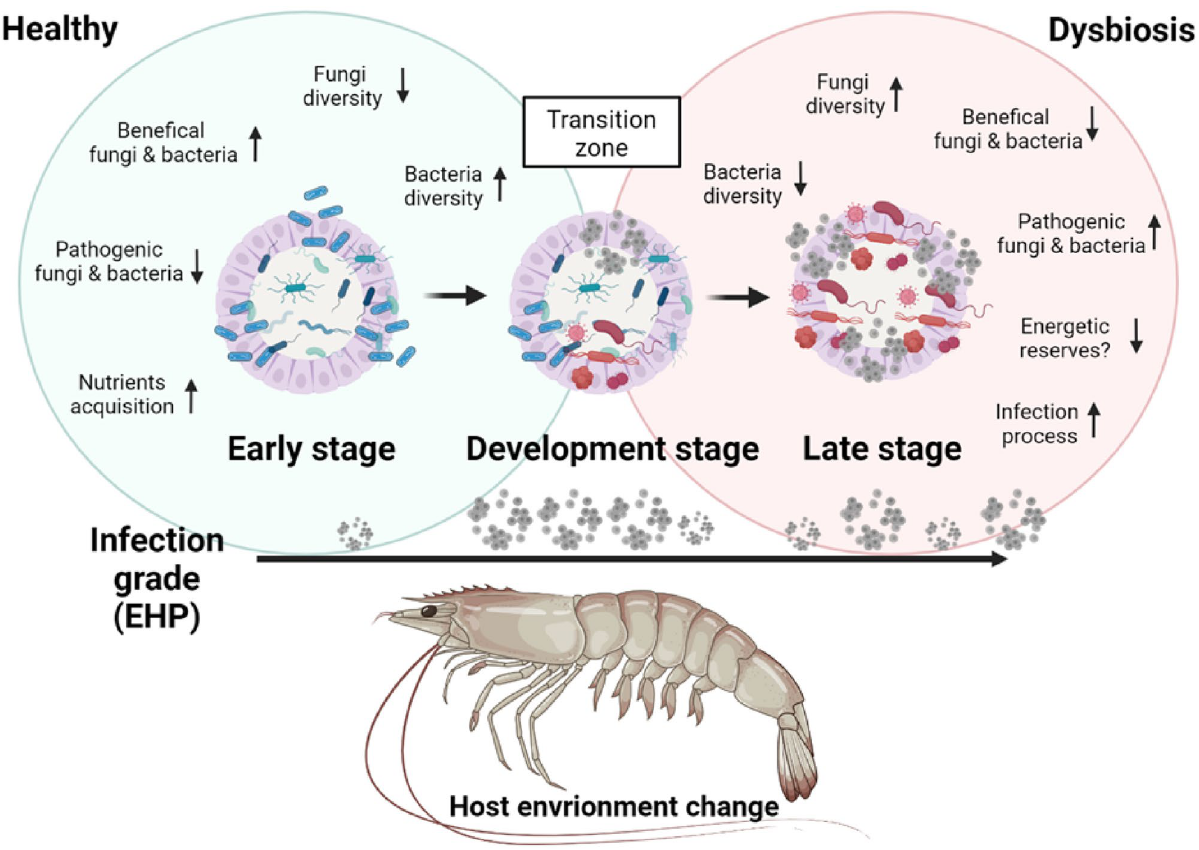
Figure 8. Modulation of the microbiome in the hepatopancreas of shrimp ( P. vannamei ) infected with EHP. Schematic diagram that represents the main changes produced in the host hepatopancreatic environment during the infection of EHP (30 days) according to the disease stages registered in this study. Infection intensity represents the cyclic patter of EHP, where bigger EHP figures represent higher infection grade and smallest EHP figures represent lower infection grade. Blue bacteria: beneficial microbiota; Gray dots: EHP; Red bacteria: opportunistic and pathogenic microbiota. This image was created with BioRender (http:// biore nder.